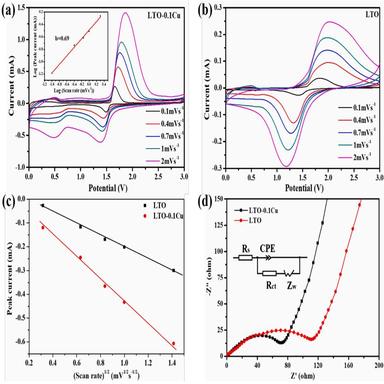
CV curves for LTO-0.1Cu composite (a) and LTO composite (b). The relationship between the peak current and the square root of the scan rate (c) and Electrochemical impedance spectra (d) of the LTO-0.1Cu composite and LTO electrodes. b values of logarithm scan rate to logarithm peak current (insert part of Fig. 5a) of the LTO-0.1Cu composite.